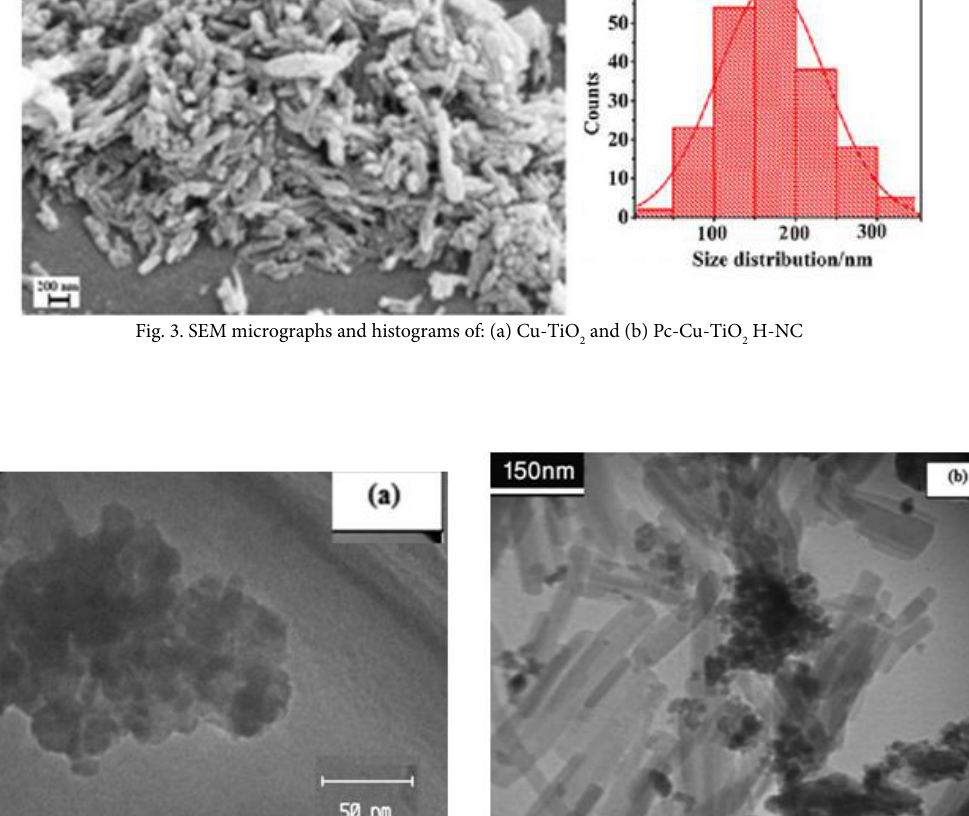
Figure 4. TEM micrographs: (a) Cu-TiO 2 and (b) Pc-Cu-TiO 2 H-NC